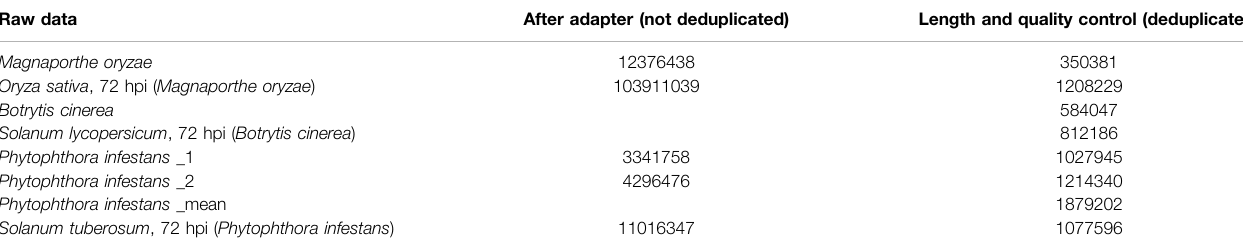
TABLE 1 | Data volume statistics before and after removing adapters, length and quality